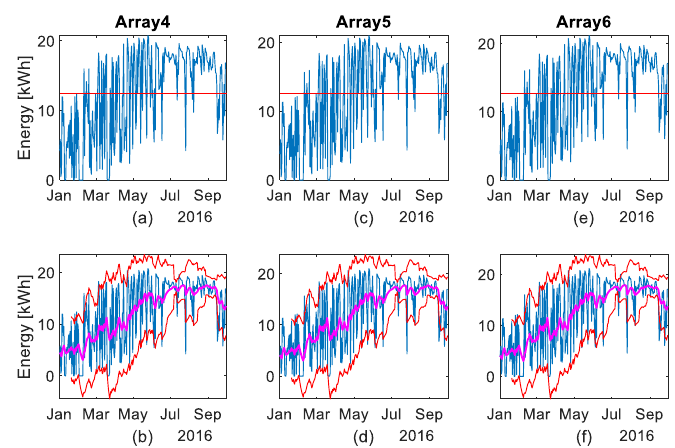
Figure 8. ( a ) Energy produced by array #4 in nine months and its mean value as red line; ( b ) upper and lower BB 20 of array #4 in red color, and EMA 20 in magenta color. ( c ) and ( d ) refer to array #5. ( e ) and ( f ) refer to array #6. Table 3. Mean energy and spread with respect to the global mean for the nine-month analysis.